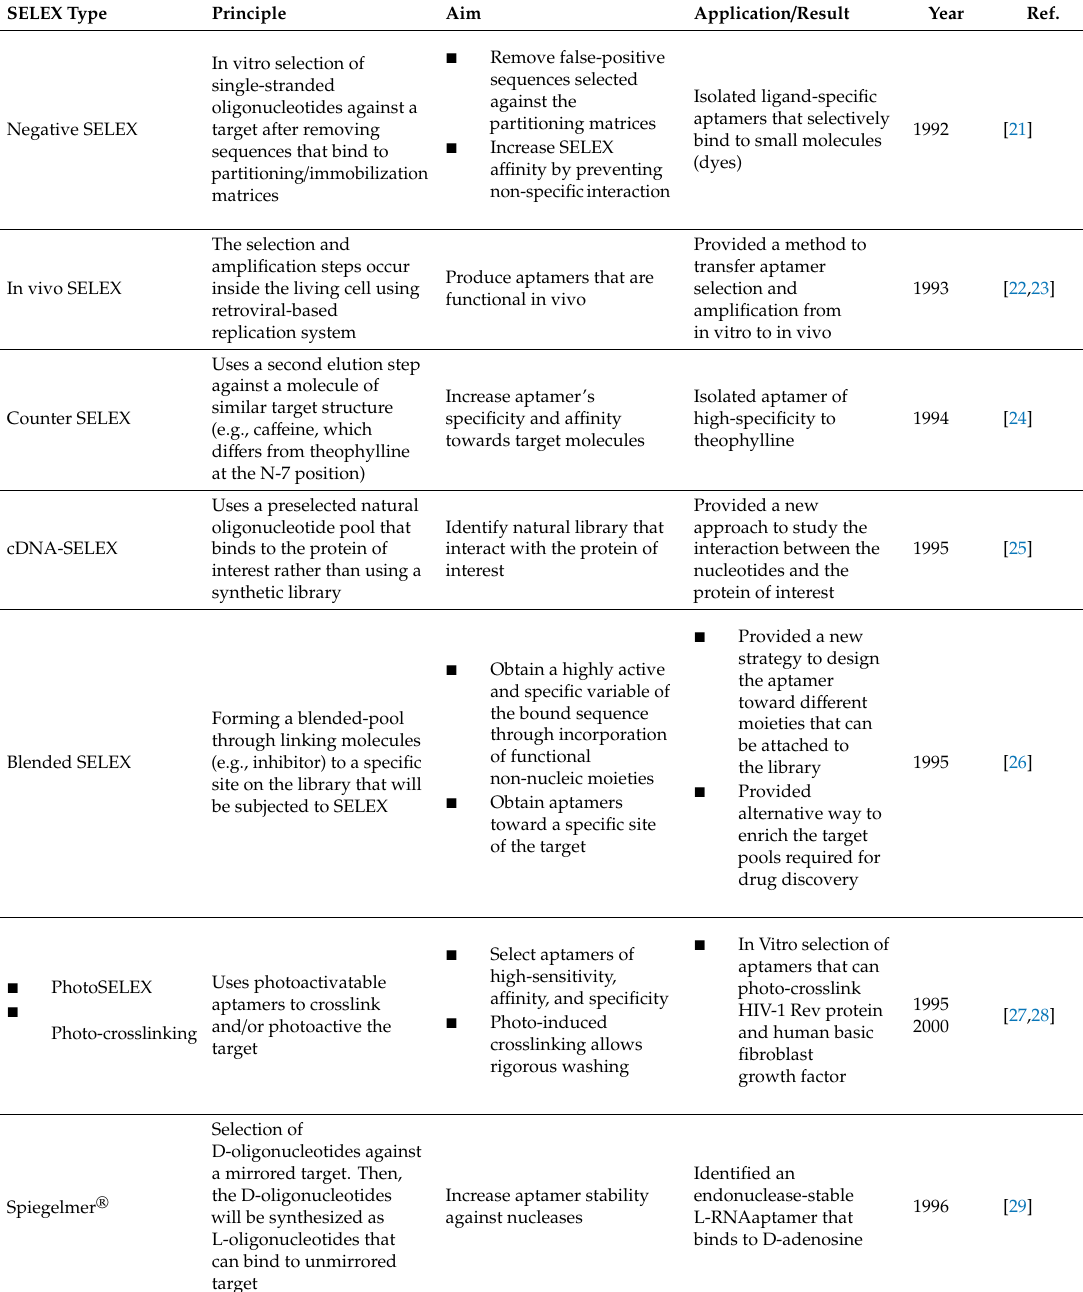
Table 1. Important strides in SELEX